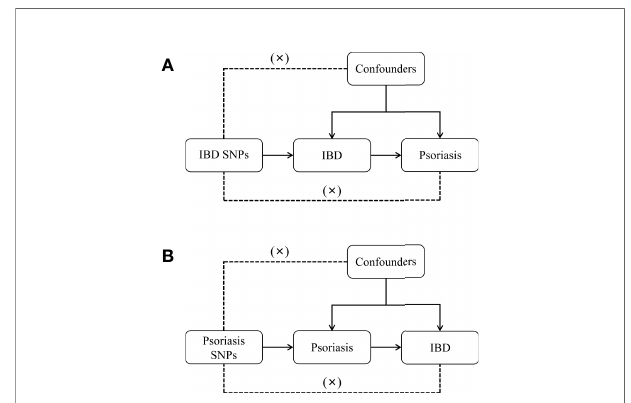
FIGURE 1 | Diagram for key assumptions of MR analyses. (A) IBD SNPs were used as the genetic instruments to investigate the causal effect of IBD on psoriasis. (B) Psoriasis SNPs were used as the genetic instruments to investigate the causal effect of psoriasis upon IBD. Line with arrows indicates that the genetic instruments (SNPs) are associated with the exposure and could only affect the outcome via the exposure. Dashed lines indicate that the genetic instruments (SNPs) are independent of any confounding variables between the results. IBD, in fl ammatory bowel